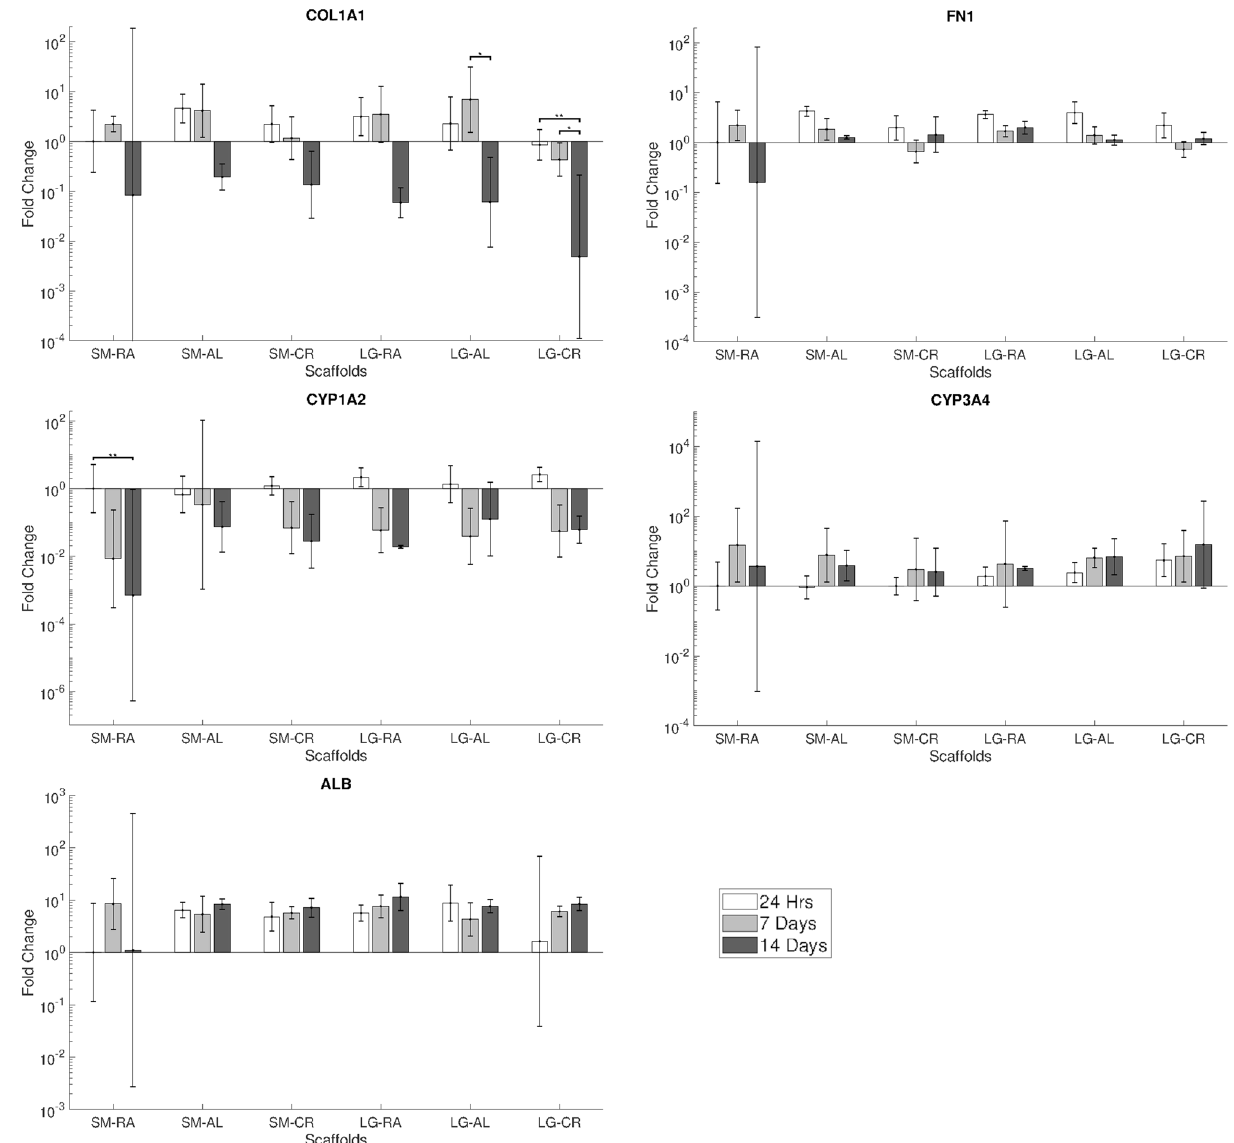
Figure 6. RT-qPCR gene expression results showing fold change of COL1A1, FN1, CYP1A2, CYP3A4 and ALB for hepg2 over 14 days. Results normalised to hepg2 on SM.RA at 24 h. N ≤ 5, Error bars = SD and *p < 0.05, **p < 0.01 and ***p <